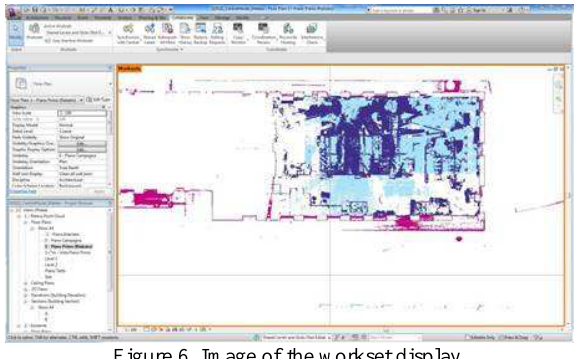
Figure 6. Image of the workset display.